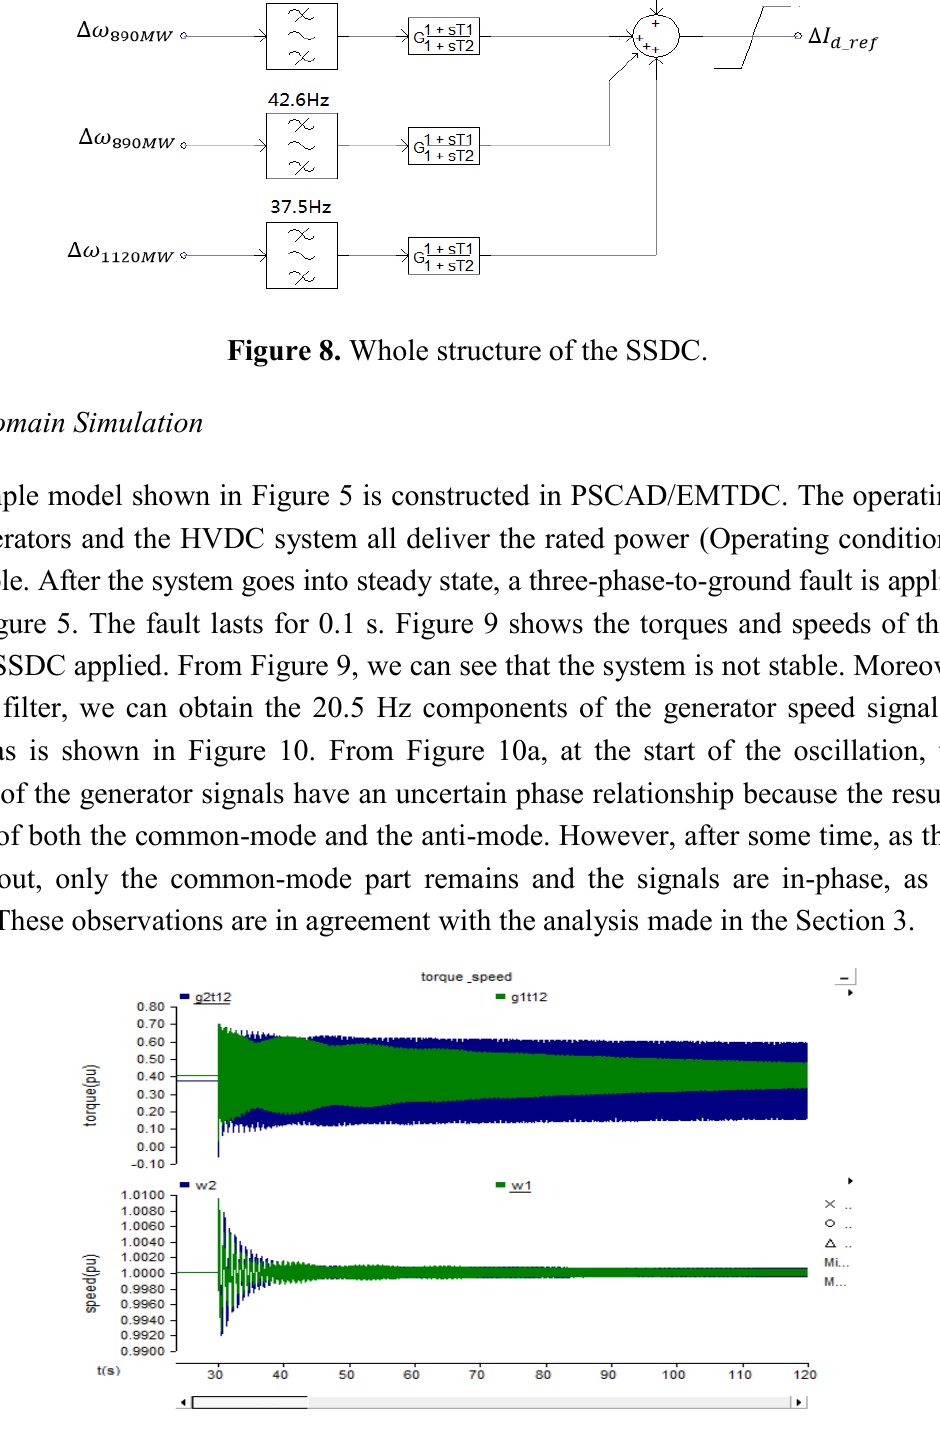
Figure 9. Torques and speeds of generators when SSDC is not